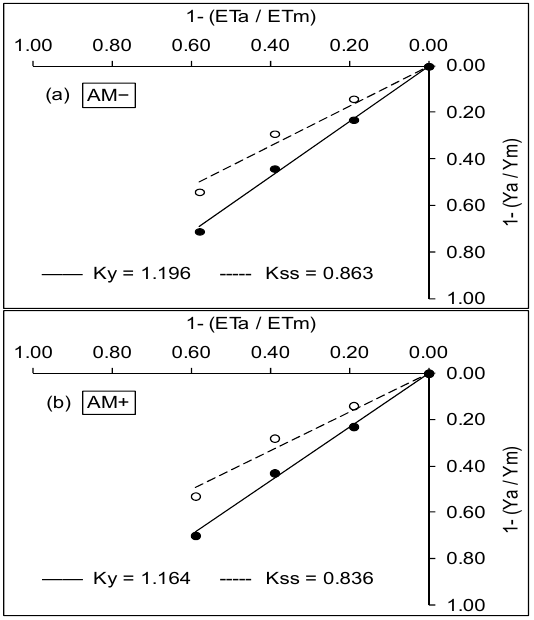
Figure 3. Relative yield decrease and total dry biomass relative decrease as a function of the relative ET decrease, measured in eggplant subjected to varying water stress and AM inoculation (pooled AM − ( a ) and AM+ ( b ) of the two years).